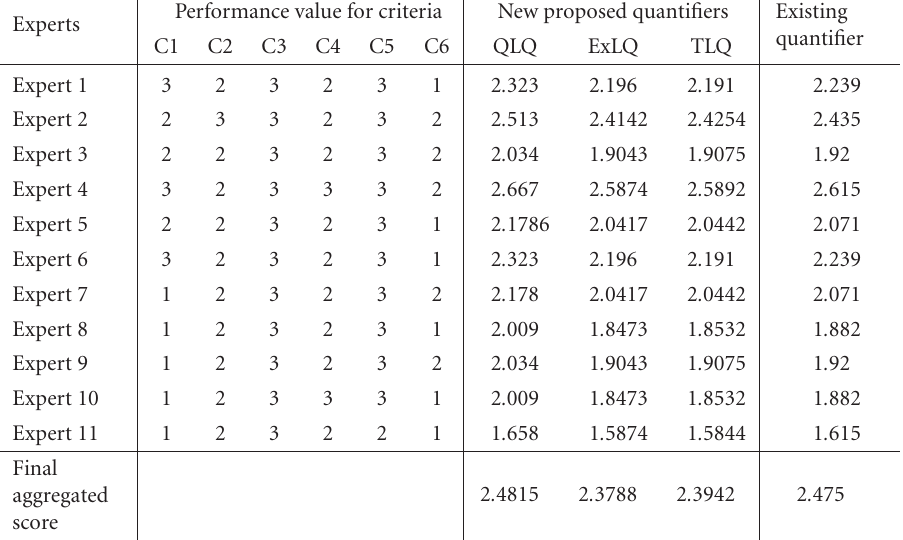
Table 4.4. Aggregated scores for proposed and existing quantifiers for a collection of six criteria.